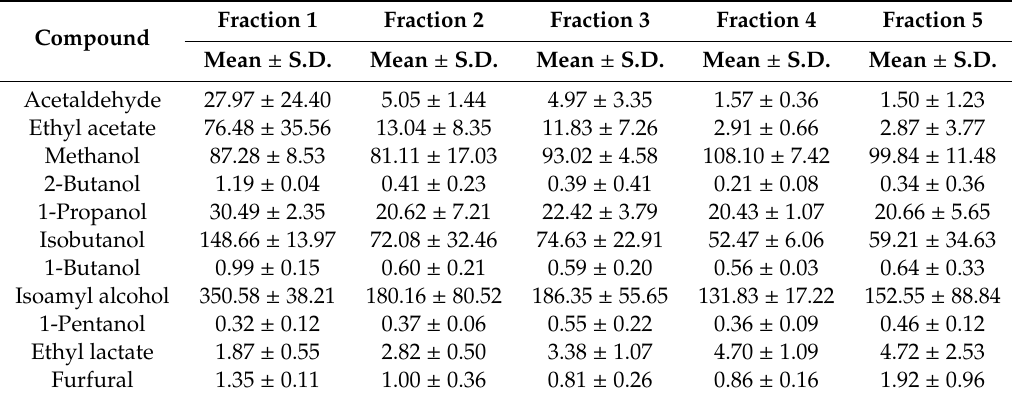
Table 2. Chromatographic characterization of tequila fractions of continuous distillation.